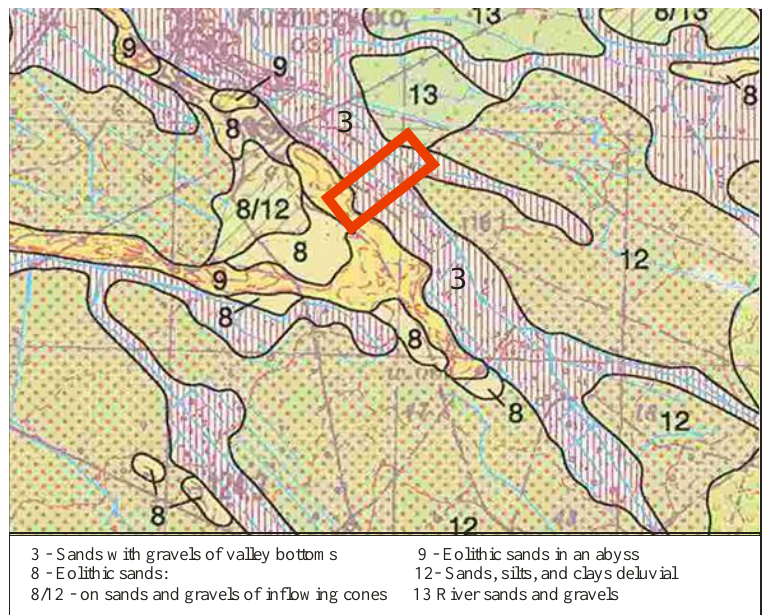
Figure 2. Detailed geological map of Poland, with a scale of 1:50,000, Czeszów chart [31].